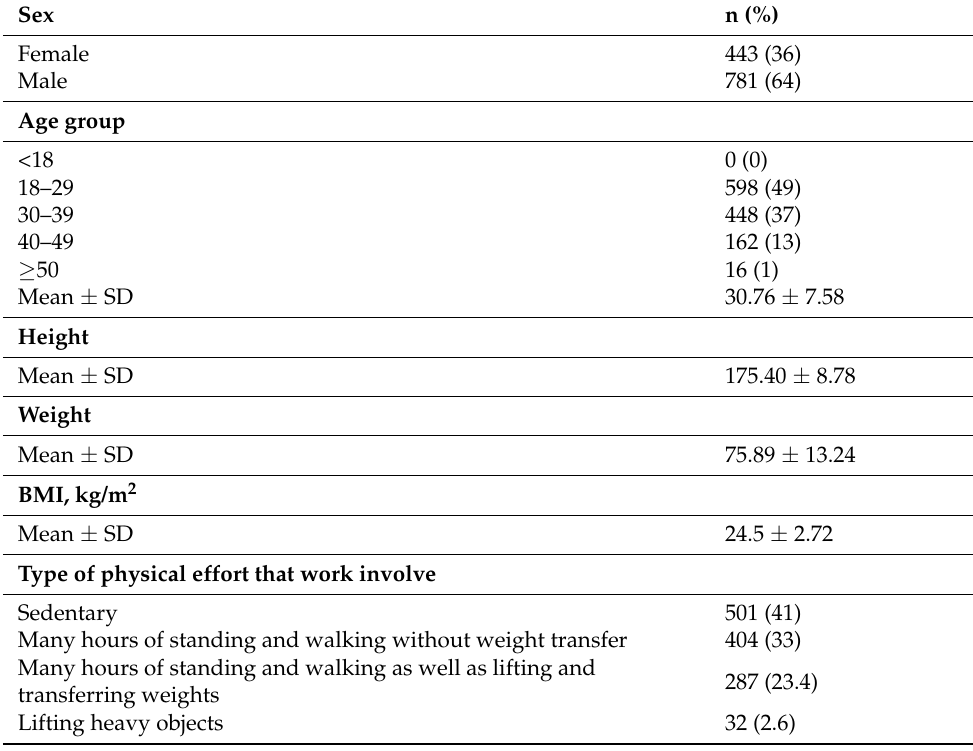
Table 1. Demographic Data and